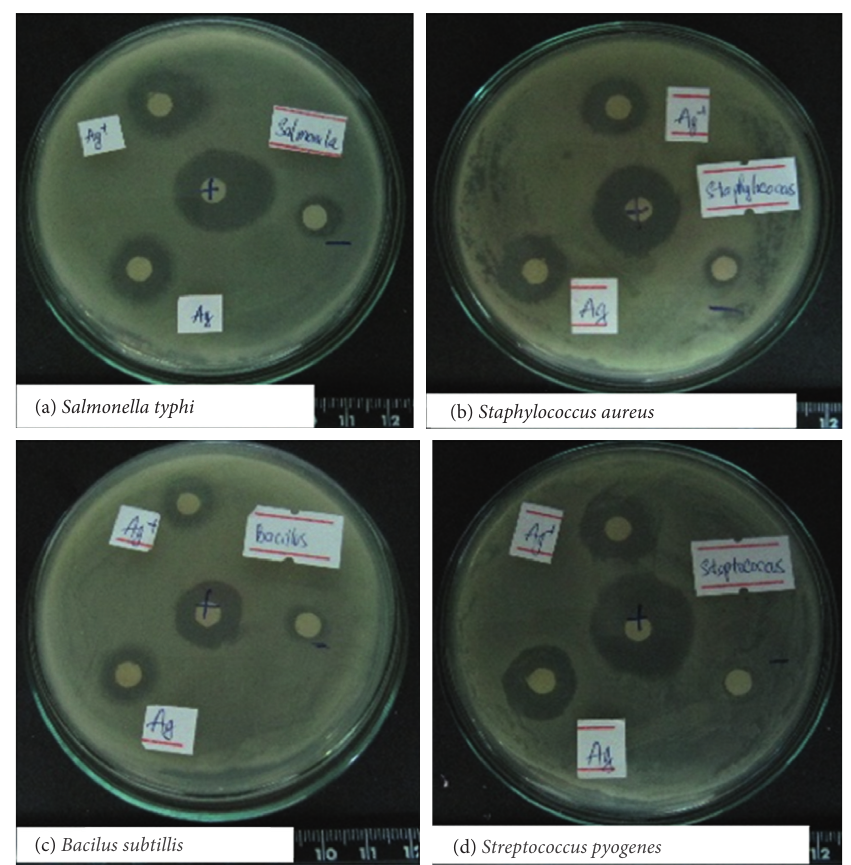
Figure 8: Antibacterial activity of AgNPs in comparison with AgNO Table 1: Diameters of inhibition zones (mm) in the antibacterial tests of AgNPs/PPE, PPE, kanamycin, and AgNO